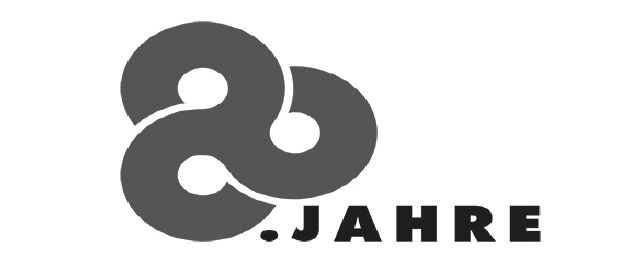
Fig. 13. Erdem Özil: Fakir’s 80th Anniversary Emblem and